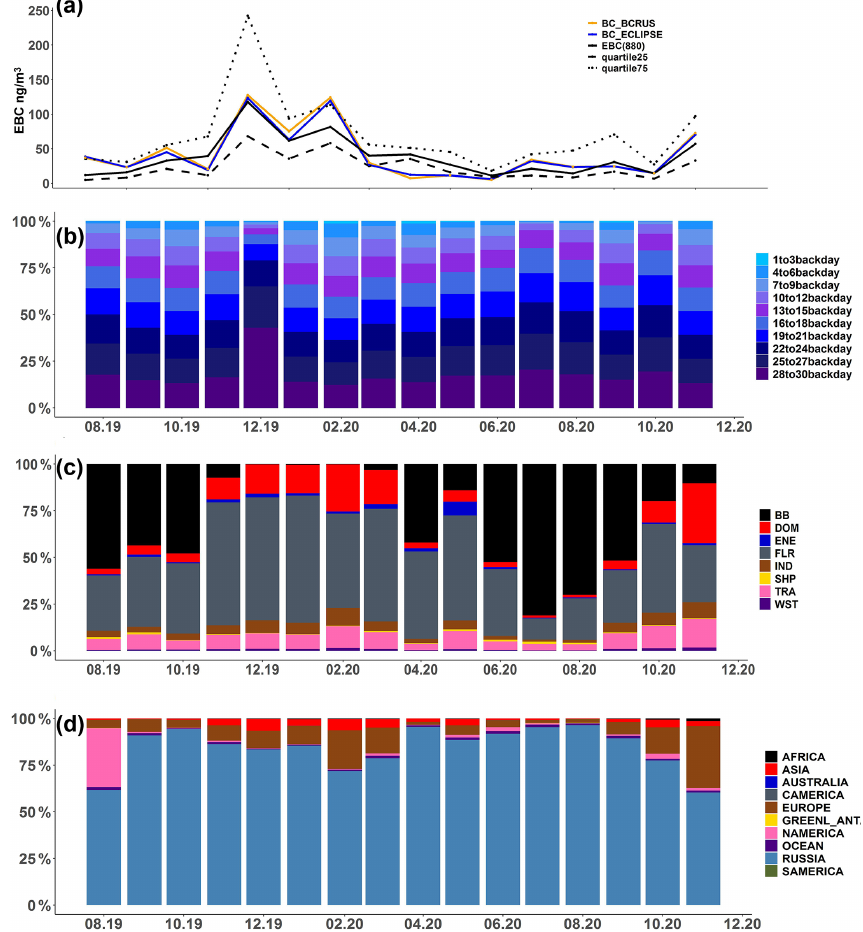
Figure 4. (a) Monthly climatology of EBC at the Island Bely station depicting medians and 25th and 75th percentiles (dashed lines). Near-surface monthly median BC concentrations simulated with FLEXPART coupled to ECLIPSEv6-CAMS (steel blue) and ECLIPSEv6- BCRUS-CAMS (red) emissions are also shown. (b) Age spectrum of modeled BC from all possible sources showing the contribution of emissions from each day back in time to the surface concentration of BC. (c) Contribution from different emission source types to surface BC concentrations. The emission sources of biomass burning (BB) adopted from GFEDv4.1 and residential and commercial (DOM), power plants, energy conversion and extraction (ENE), gas flaring (FLR), industrial combustion and processing (IND), shipping (SHP), and transportation (TRA) adopted from ECLIPSEv6 were considered. (d) Continental spectrum showing the contribution from each continent or region to surface BC concentrations; 10 regions were considered, namely Africa, Asia, Australia, Central America, Europe, Greenland and Antarctica, North America, world ocean, Russia, and South America (see Supplement Fig.